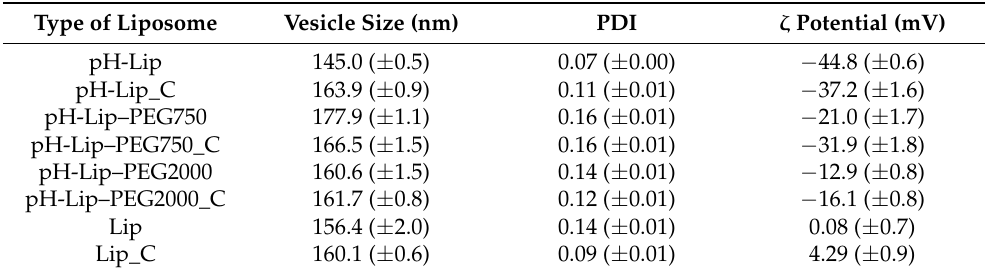
Table 1. Characteristics of liposomal formulations. Values are expressed as mean ± standard deviation. (n =